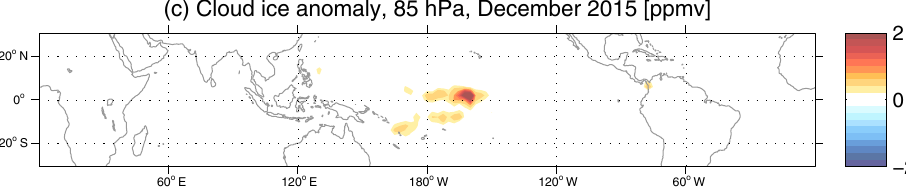
Figure 11. Annual average water anomalies at 85hPa for the GEOSCCM AGCM experiments. (a) The 85hPa water vapor between 5 ◦ S and 5 ◦ N. (b) Cloud ice at 100hPa between 5 ◦ S and 5 ◦ N. The thick brown line in (a) indicates the average across all 42 AGCM integrations. A black line indicates the ensemble mean of the five integrations which have been extended to the near present, and color indicates each of these five simulations. (c) Cloud ice anomalies at 85hPa in December 2015 in the ensemble mean of these five simulations. No detrending has been performed on any of the time